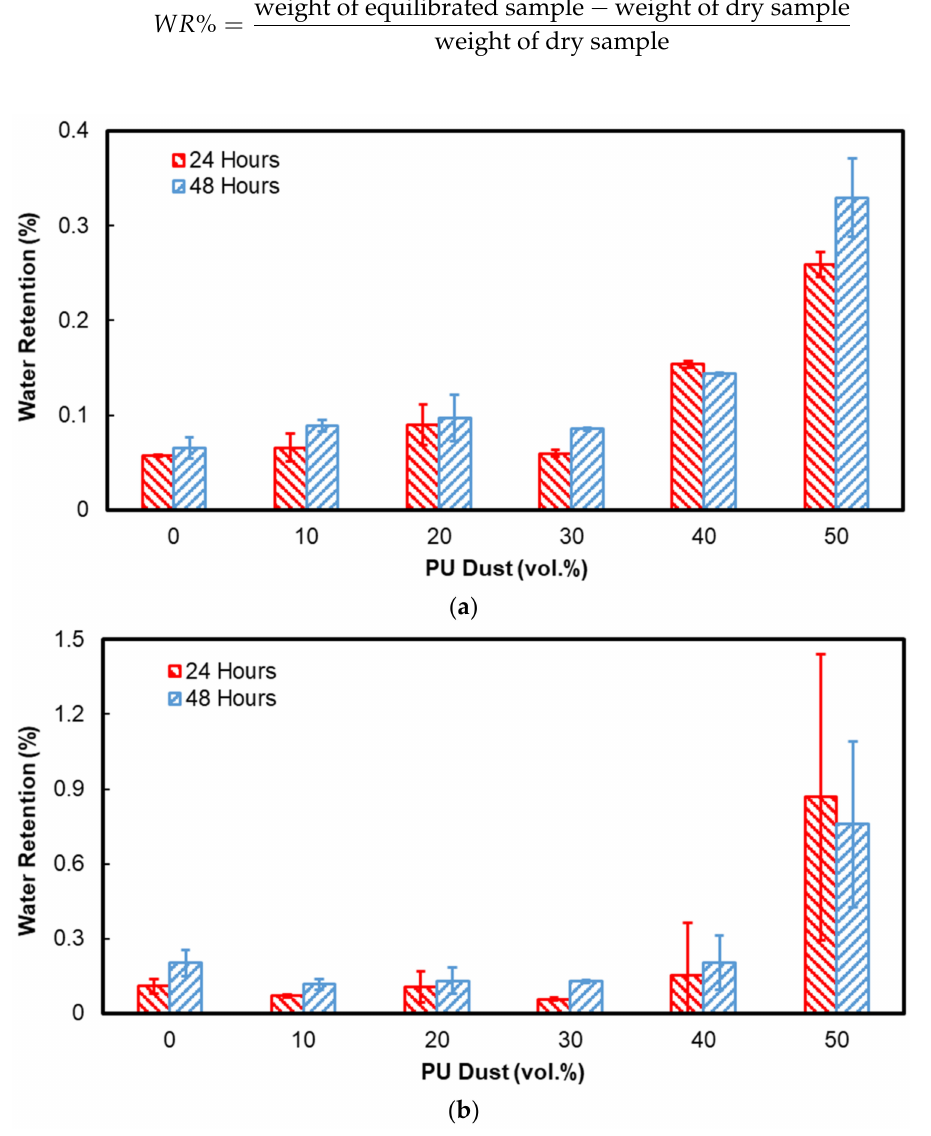
Figure 9. Water retention for UPR-PUD composites ( a ) at room temperature and ( b ) at 50 ◦